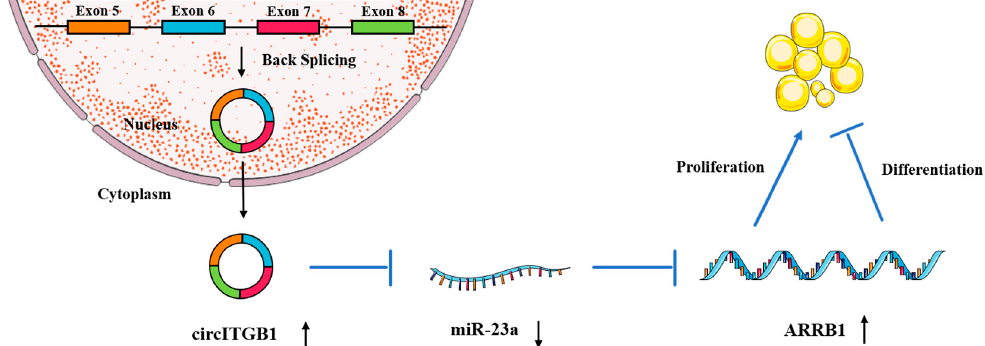
Figure 8. Hypothetical model for the interaction of circITGB1 with miR-23a and its effects on ARRB1 and adipocyte proliferation and differentiation. CircITGB1 enhances ARRB1 expression by acting as a miRNA sponge. CircITGB1 enhances the proliferation of adipocytes and inhibits their ability to differentiate, thereby inhibiting the progression of lipid droplet formation.